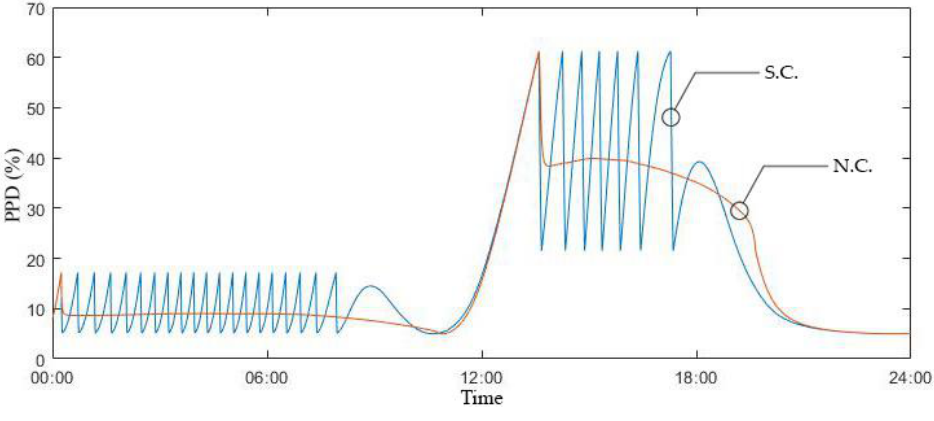
Figure 7. Comparison of the predicted percentage of dissatisfied (PPD) between SC and FC.